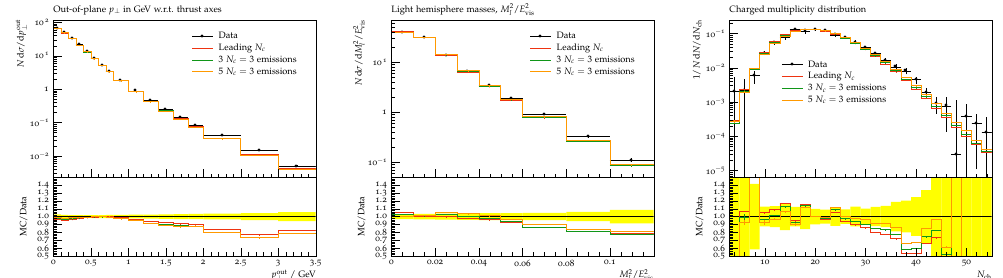
Figure 5 . Out-of-plane p ? w.r.t. the thrust and thrust major axes (left), light hemisphere mass (middle) and fraction of events containing N ch charged particles, using to data and Rivet analyses from [59,